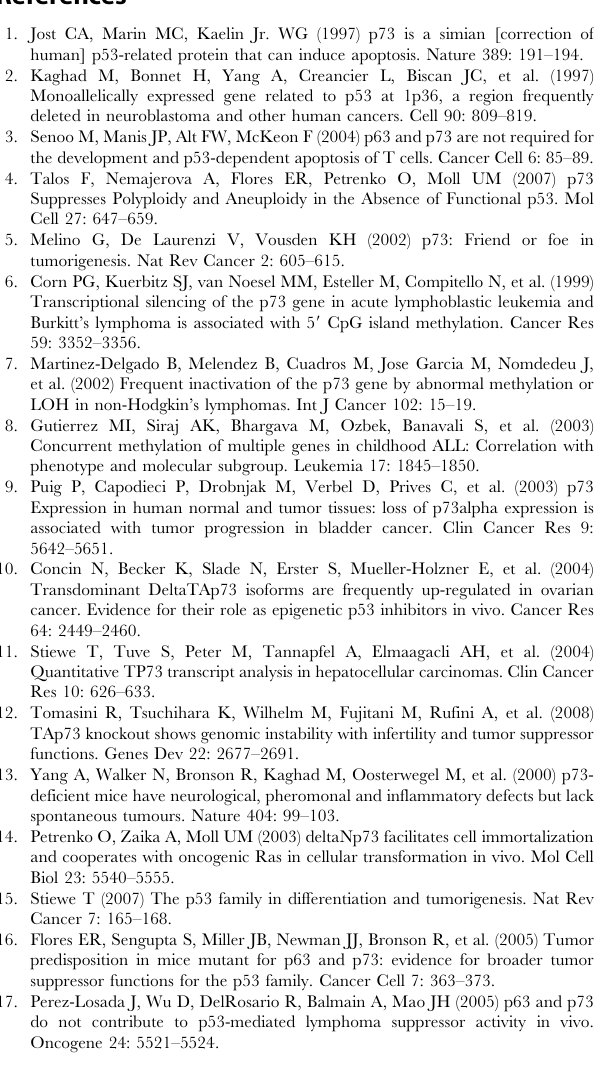
Figure S1 A. Total cell numbers in thymi of ageing mice of the indicated genotypes. The error bars represent the standard error obtained from three experiments. B. Kaplan-Meier curves of tumor-free survival of p53 + / 2 and p53 + / 2 p73 2 / 2 mice. The number of mice of each genotype is indicated. C. Tumor spectra in mice of the indicated genotypes. Figure S2 Quantitative RT-PCR analysis of genes encoding critical factors of T cell development in DN (A) or DP thymocytes (B, C) of the indicated genotypes. Each sample was analyzed in duplicate. mRNA expression levels were normalized to hypoxan- thine-guanine mRNA amount.